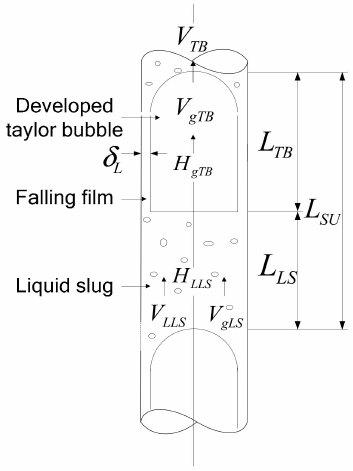
Figure 3. Schematic of developed slug